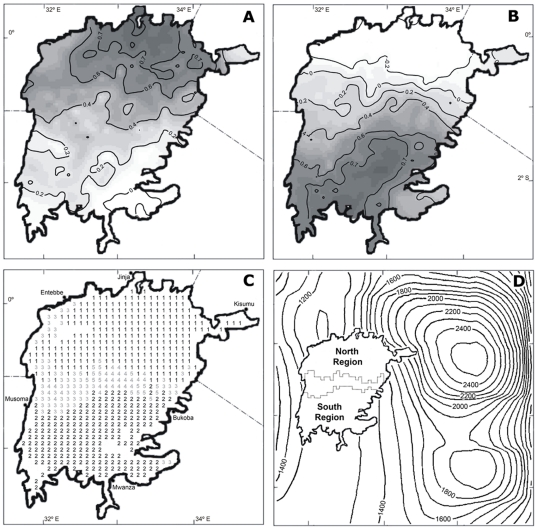
Bio-optically co-varying regions in Lake Victoria.(A) Spatial pattern of the Pearson correlation coefficients between the mode 1 and the OC4v4-chl time series of the lake-sections. (B) Spatial pattern of Pearson correlation coefficients between the mode 2 and the OC4v4-chl time series. (C) Contour lines were obtained by kriging interpolation. Spatial distribution of the most representative mode (highest R) for each lake-section. (D) Classification of Lake Victoria in regions sharing similar bio-optical co-variation. The Transitional Region between North and South Regions is delimited by dotted lines. The topography of the study area is also shown through the contour heights (in meters) interpolated from a 10' dataset.